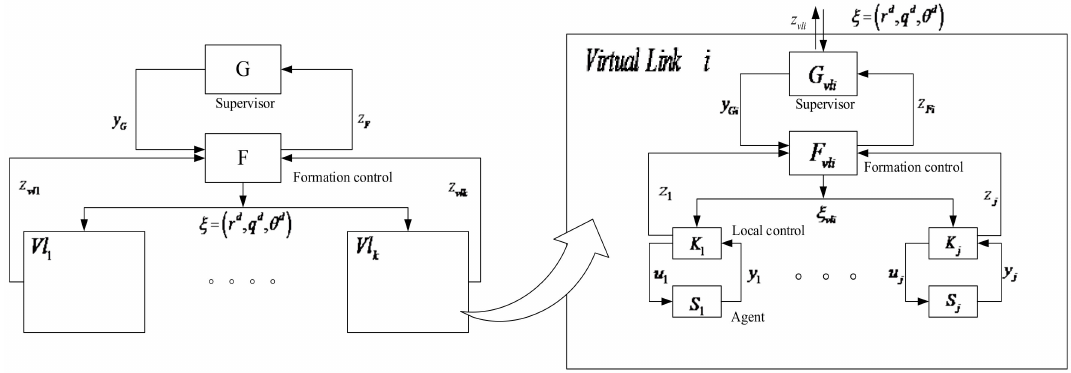
Figure 6. Architecture of the virtual